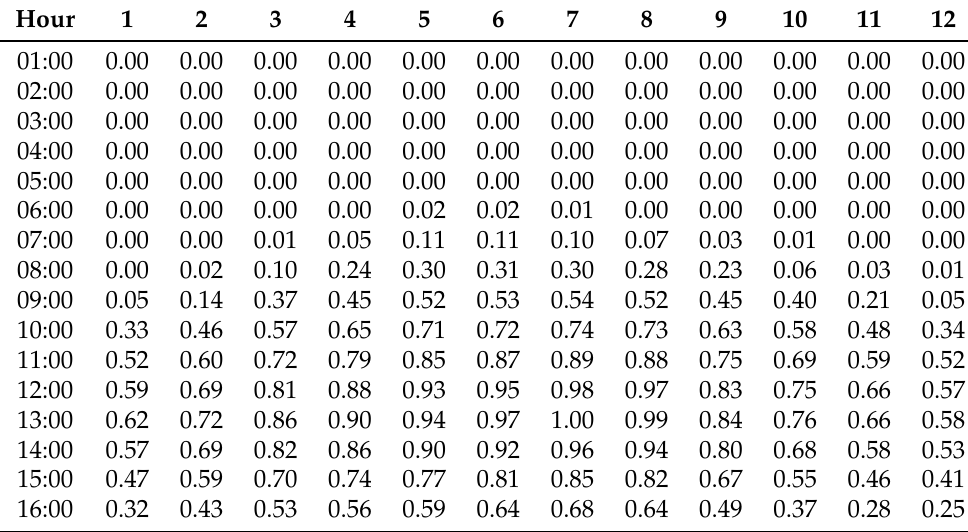
Table A2. Normalized solar power profile